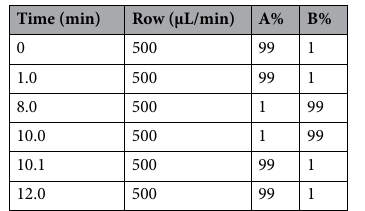
Table 1. Condition parameters of mobile phase (sample volume: 1